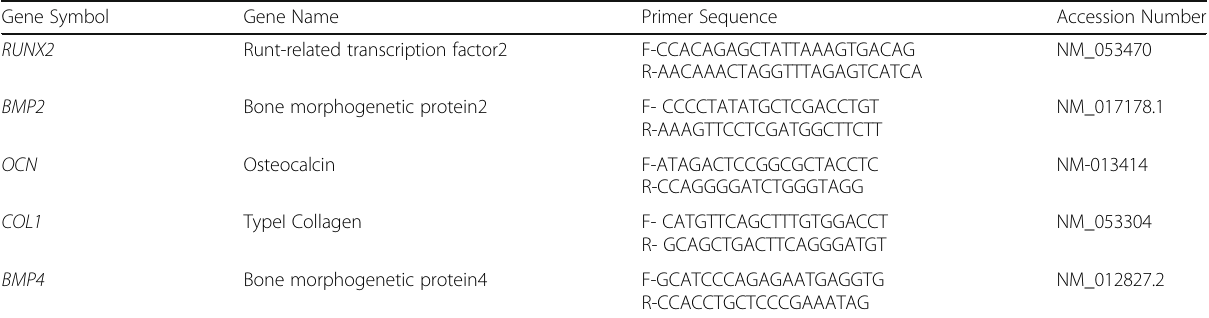
Table 1 Primer sequence of various genes used for